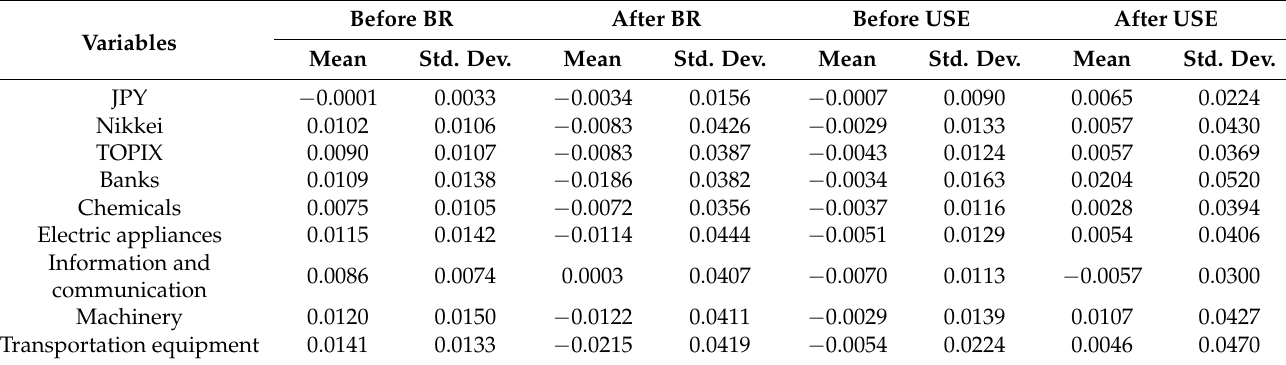
Table 8. Mean and standard deviation for five days before and after each event. Author’s estimations based on the data from the Bank of Japan, TSE and Yahoo Finance.